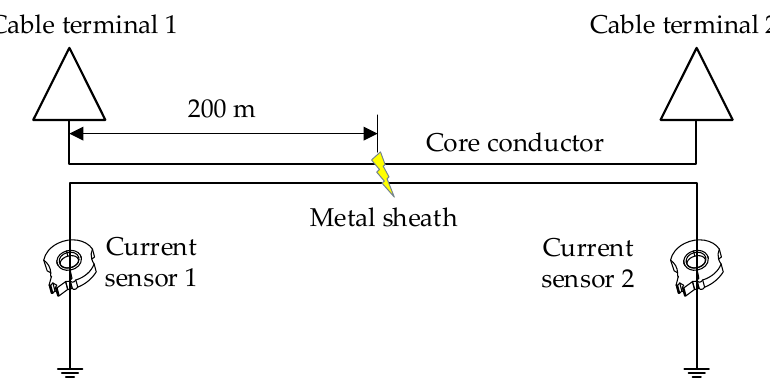
Figure 17. The configuration of a double-end bonded MV cable system: note, ‘core conductor’ has three cores, one for each phase. Table 2. Parameters of cross-sectional structure of the MV cable.